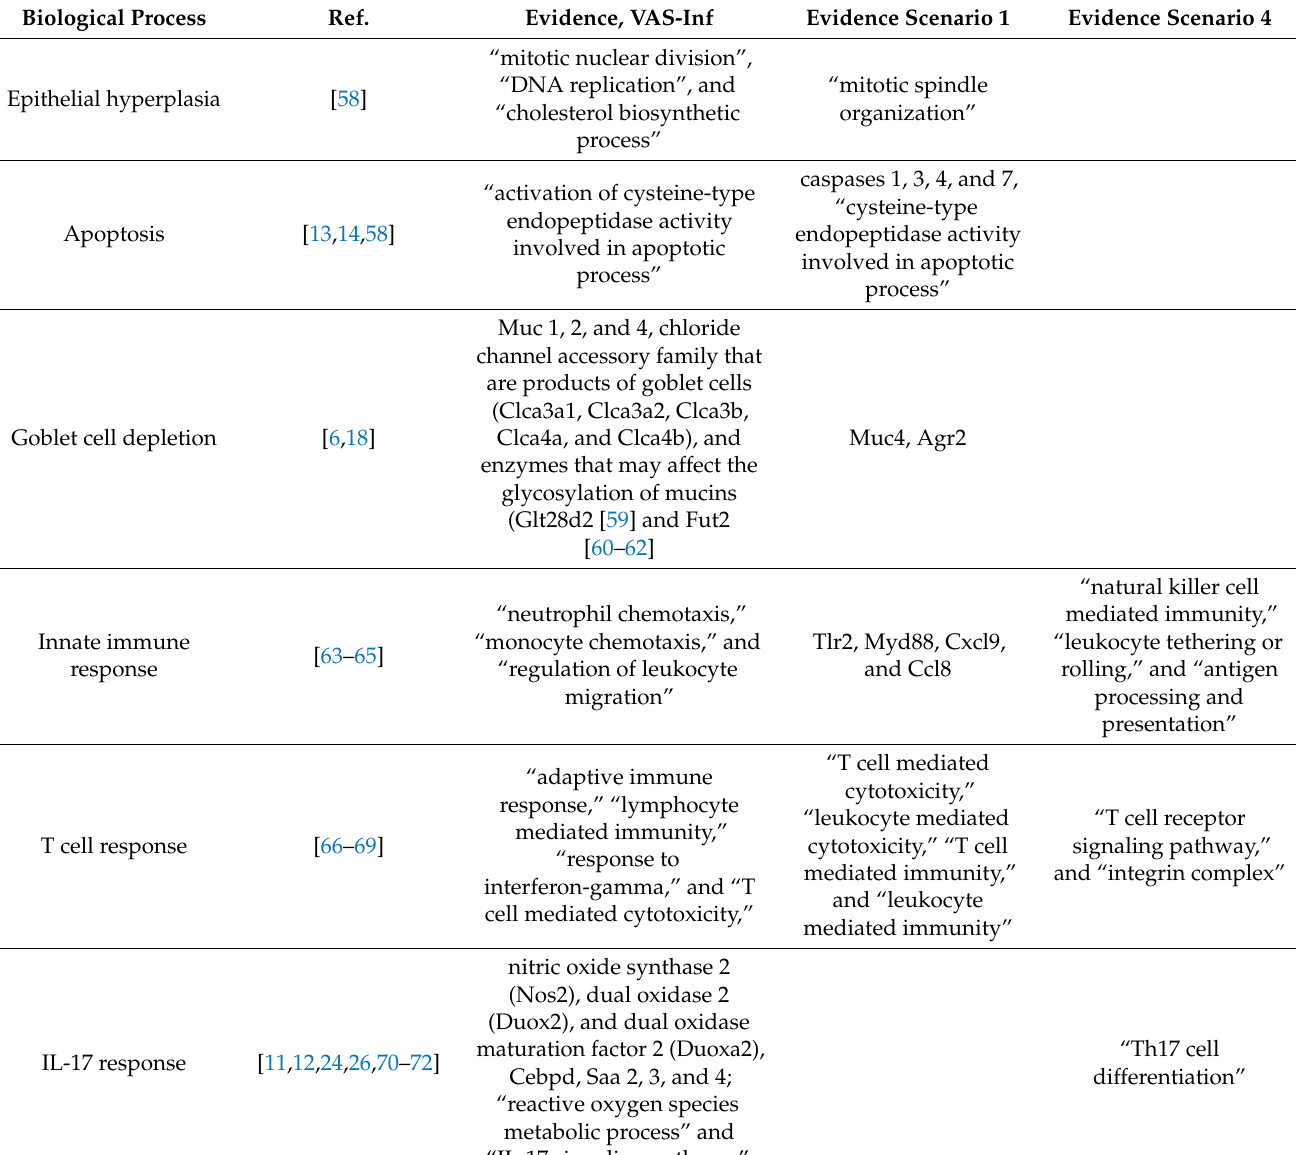
Table 1. Enrichment categories for the biological pathways and processes induced by the C. rodentium infection confirmed in the colon